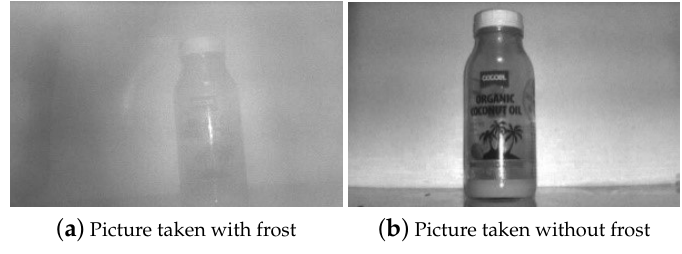
Figure 2. Sample pictures from the